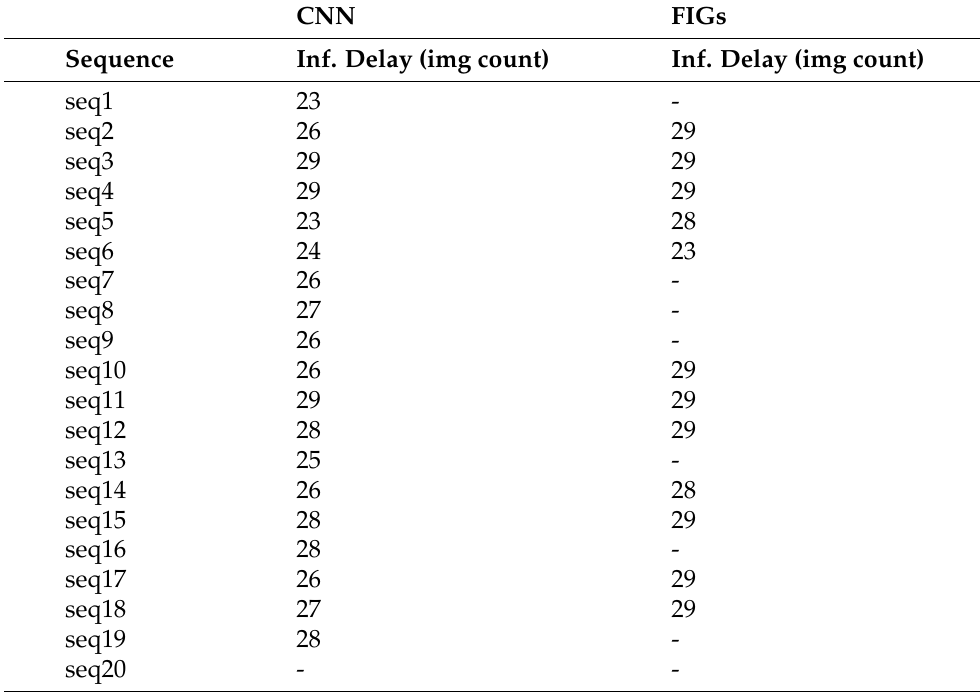
Table 4. ML algorithm inference delay (in images of camera